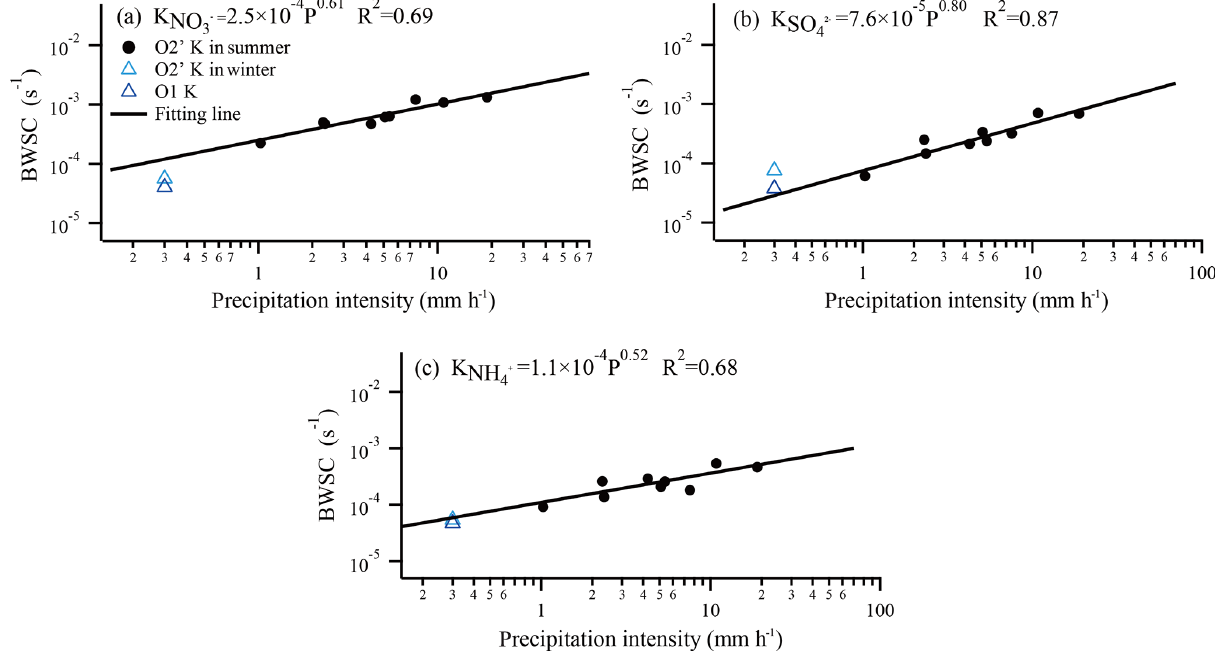
Figure 5. Scatterplots of the BWSC and precipitation intensity for NO − al. (2017); light blue triangle: O2 (cid:48) from this study; deep blue triangle: O1).